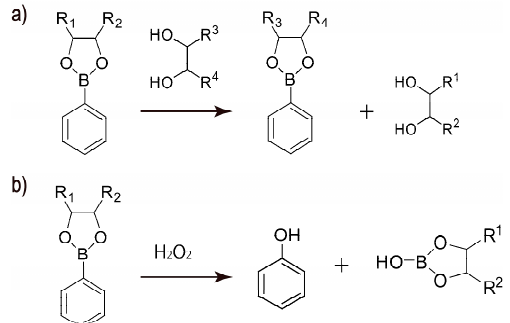
Figure 3. ( a ) Competitive binding of a diol compound to a boronate ester; and ( b ) decomposition of boronate ester by H 2 O 2 .